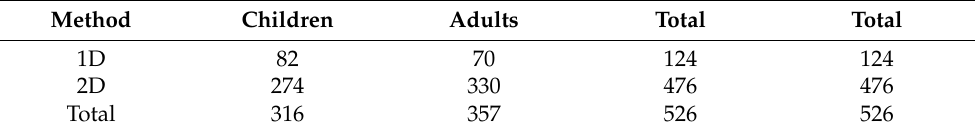
Table 2. Metabolites identified in urine from